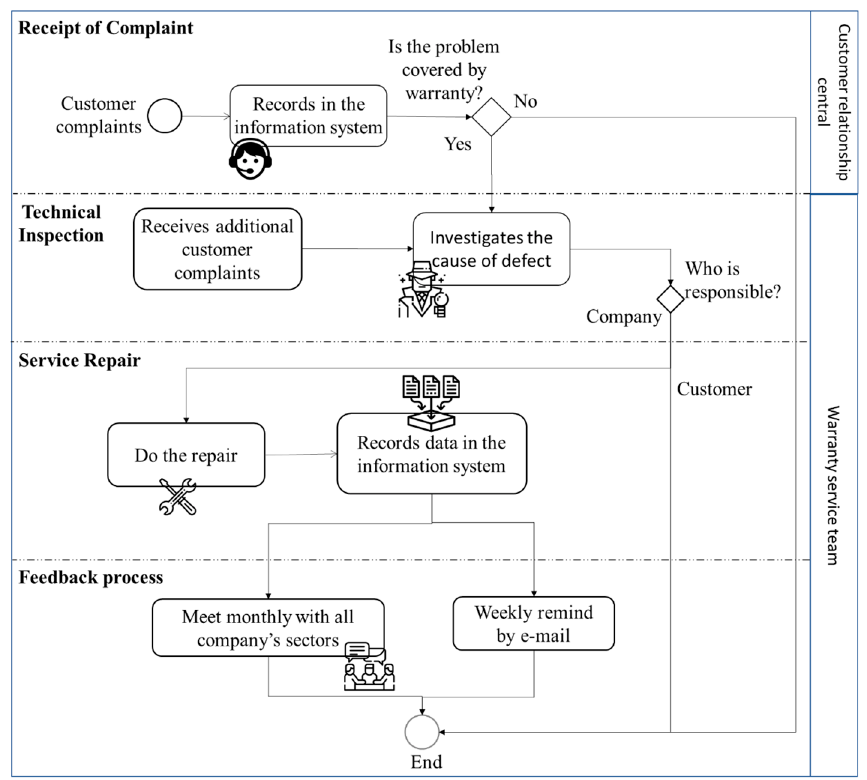
Figure 3. Warranty service